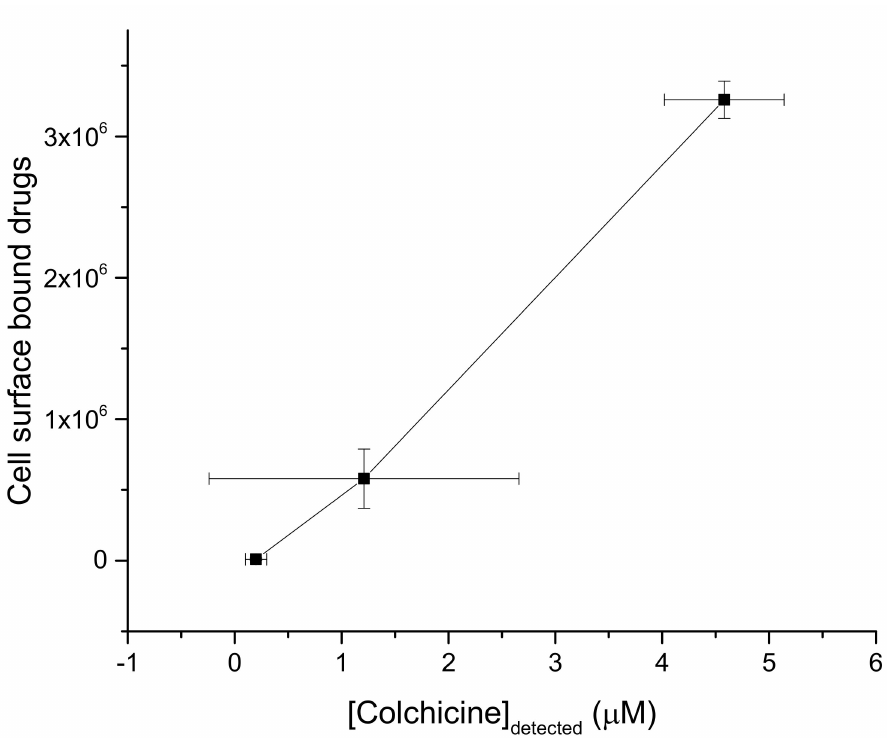
Figure 4. Comparison between number of cell surface bound colchicine molecules versus liposome adsorbed colchicine for three common aqueous Col concentrations in both investigations, namely 0 (control), 1 and 100 µ M (from the low x-y coordinates to the higher ones in the graph). The data represent for the experimental repeats, n = 3 and 5 for cell surface binding (mean ± S.D., n = 3) and liposome binding (mean ± S.D., n = 5) data, respectively. In this figure, y-axis values represent the y-axis values for N Col taken from Figure 3 and x-axis values represent the y-axis values for colchicine concentrations in DPPC liposomes taken from Figure 1,